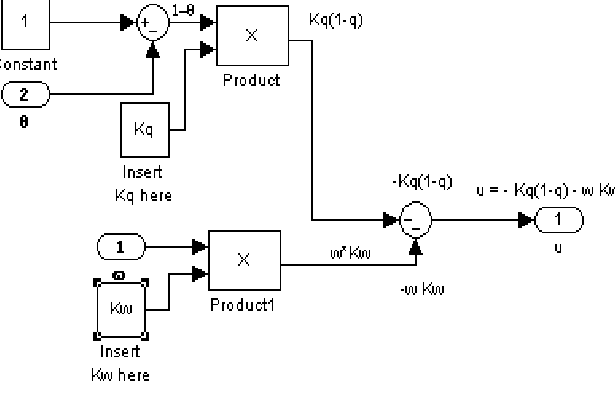
Figure 6. PD Controller Implemented in SIMULINK.